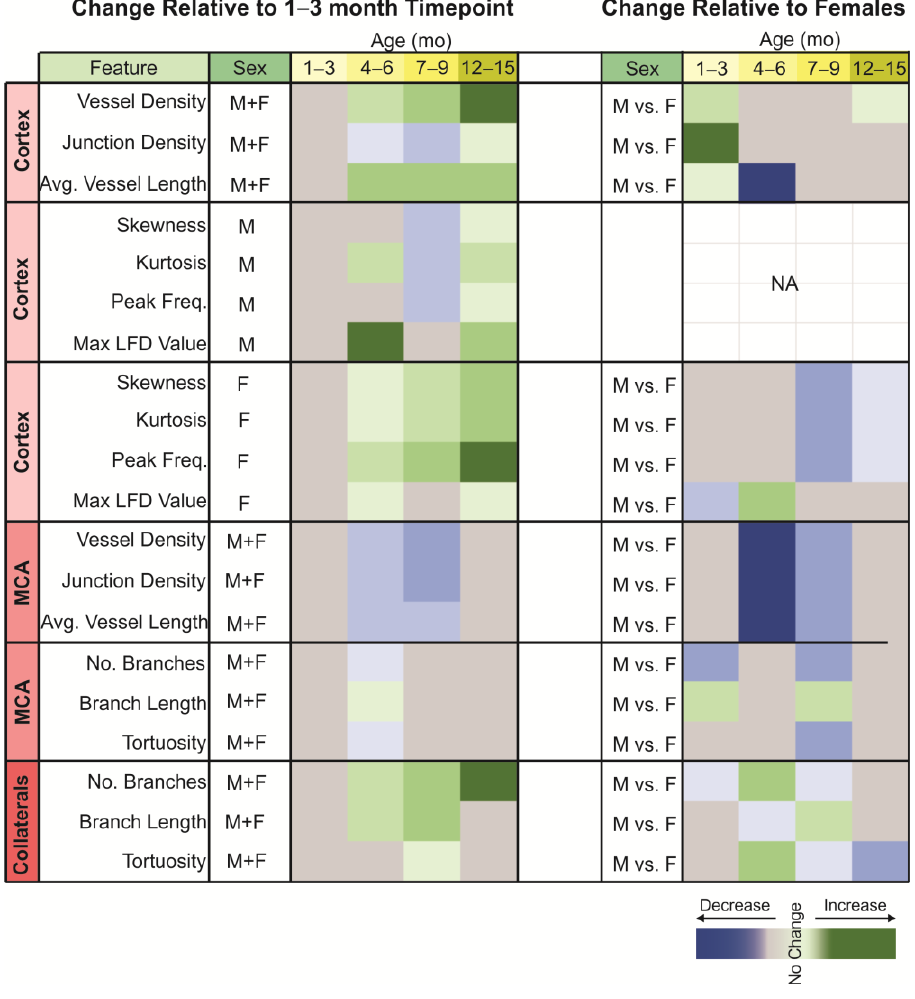
Figure 9. Summary heatmap of relative changes in the 3xTg-AD mouse with increasing age. The heatmap of the change relative to the 1 – 3 month timepoint illustrates the increasing alterations in vascular topology of the cortex with increasing age. In the middle cerebral artery (MCA), there are decreases in vascular features during mid-life. Relative to female 3xTg-AD mice, male mice predominantly showed decreased vascular features, particularly in the MCA.